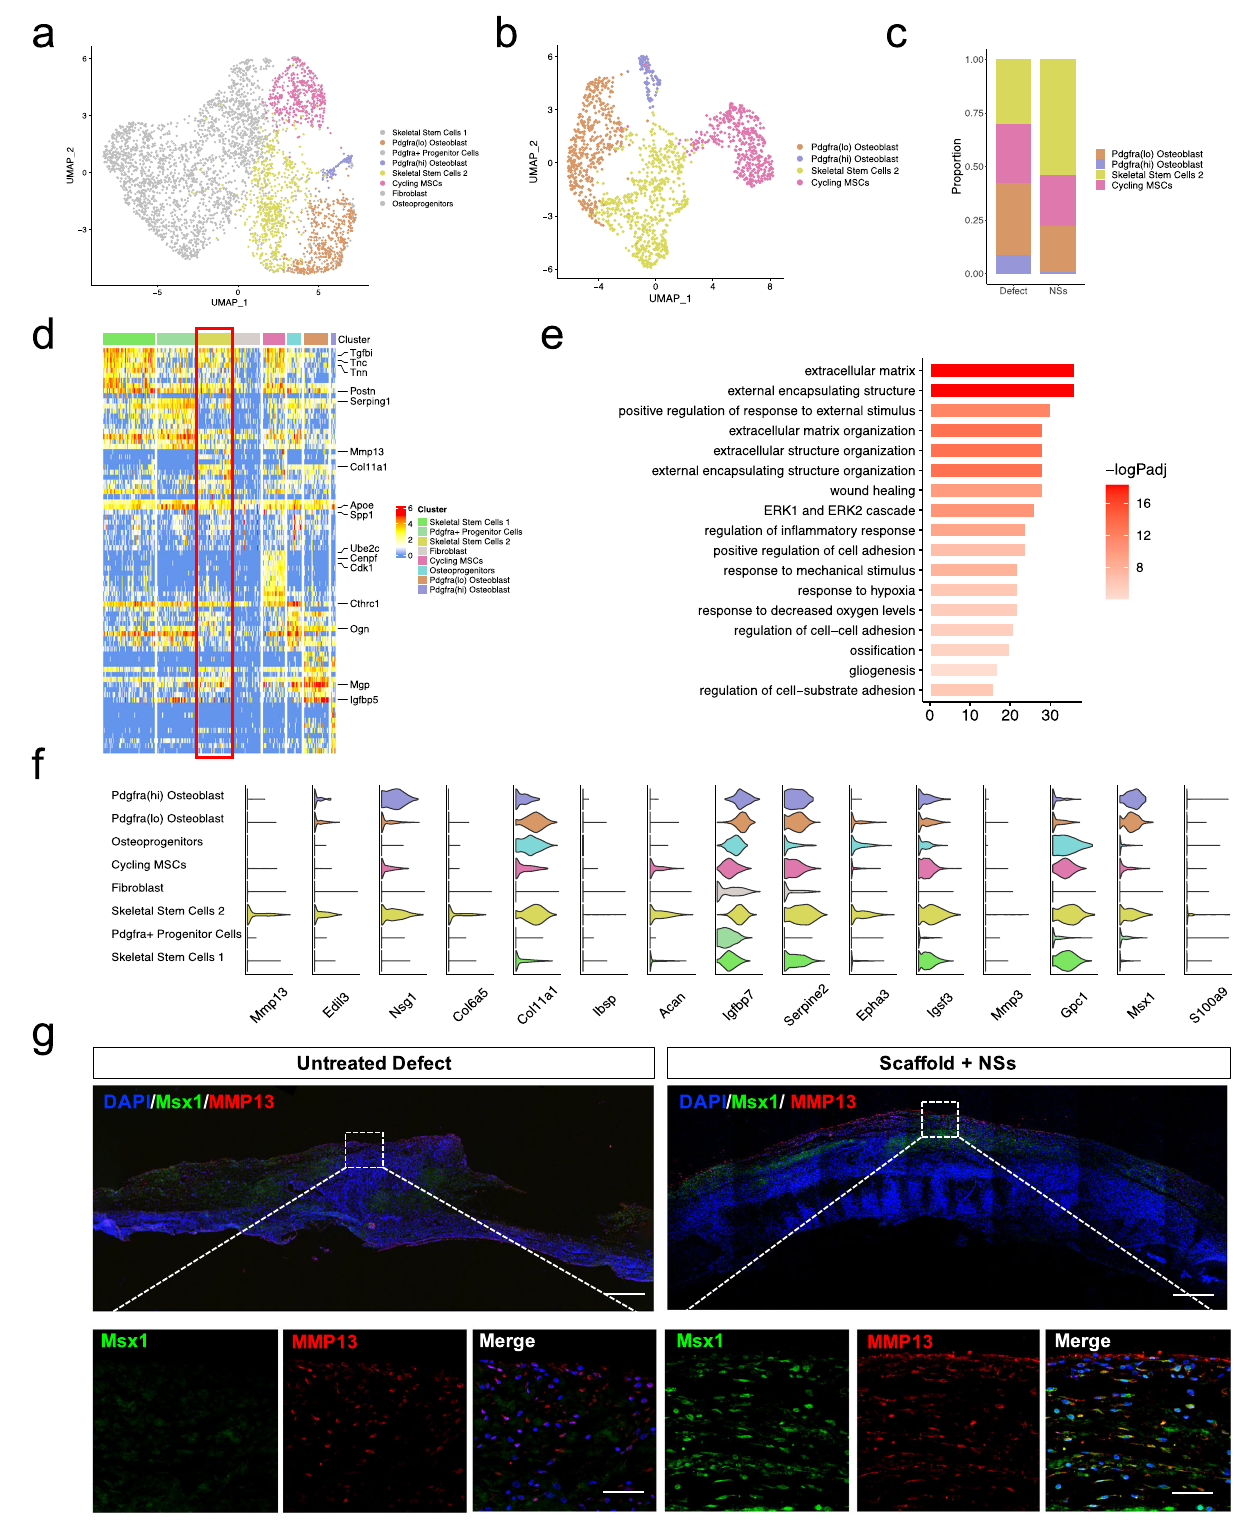
Fig. 5 | Msx1 + SSCs subset was locally expanded by the in situ culture system with NSs. a Visualization of SSC2 differentiation lineage cells in osteo-lineage cells with UMAP plot, highlighting four speci fi c subsets. b UMAP plot of the four speci fi c subsets. c Relative proportion of cell subsets between Defect and NSs group. d Heatmap and the expression of marker genes of 8 osteo-lineage sub- clusters. Marker genes are provided in source data. e Barplot showing the GO enrichment in SSC2 subset. Markers used for enrichment analysis were selected according to p value (* p <0.05, Wilcoxon Rank Sum test) and fold change (>1).